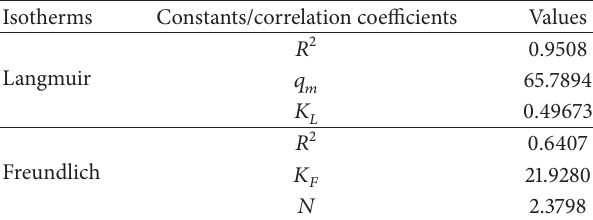
Table 1: Langmuir and Freundlich isotherm constants.